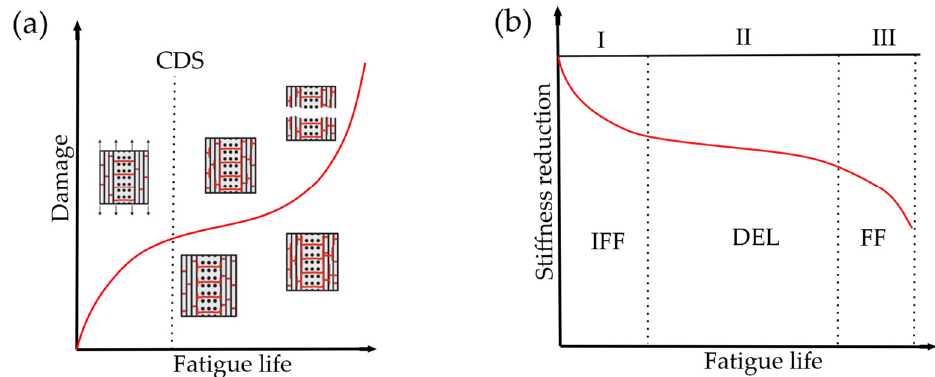
Figure 1. Fatigue failure in multilayered FRPs: ( a ) Formation of cracks, i.e., damage accumulation; ( b ) Stiffness reduction for the described failure stages [14,15] .